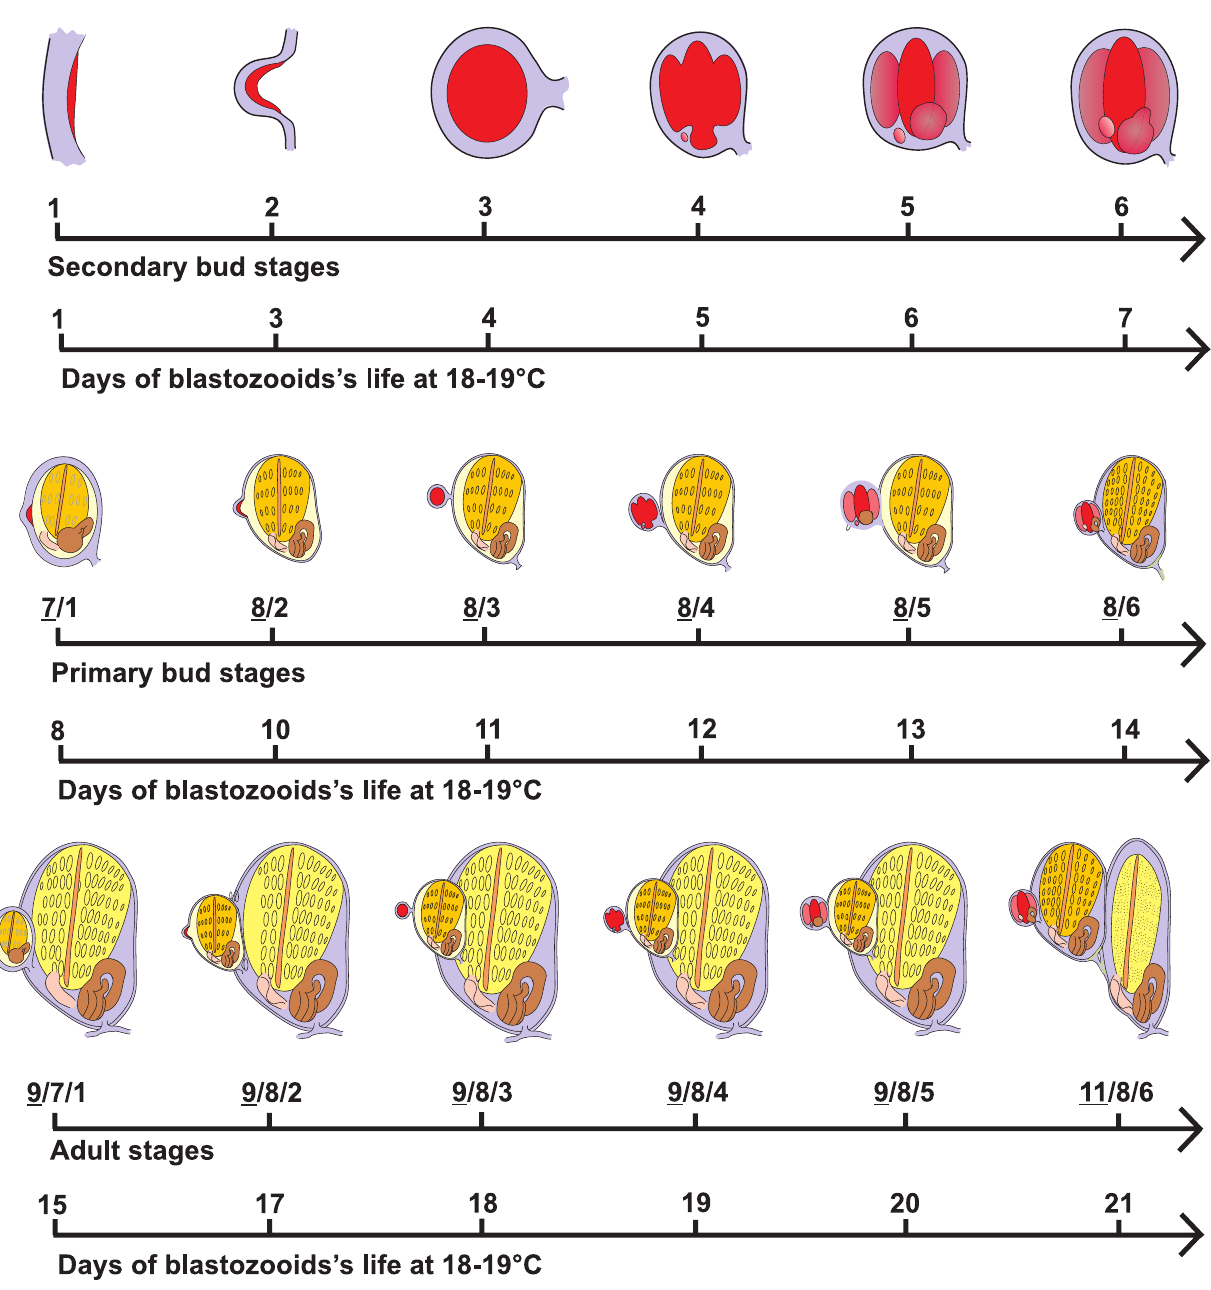
Figure 5. Developmental timetable of B.schlosseri blastozooid. The life of each blastozooid lasts about three weeks at 18–19 u C: the first week involves the maturation of the budlet, from its appearance to organogenesis mostly concluded; the second week, preceeded by a change of generation during which the budlet becomes a bud and form a new budlet, sees the bud growing, the heart beating, and the organs cytodifferentiation; the third week, again preceded by a change of generation during which the bud become adult, is characterized by filter feeding activity. See the text for details about staging method. doi:10.1371/journal.pone.0096434.g005 (BSD:0000011). The meta_period lists five high level terms: pre- (BSD:0000010) are entities comprised in the meta_period blasto- embryonic development (BSD:0000002), embryonic devel- genesis and also in the entity period. opment (BSD:0000003), metamorphosis (BSD:0000004), post-metamorphosis/oozooid (BSD:0000005) and blasto- genesis (BSD:0000001).